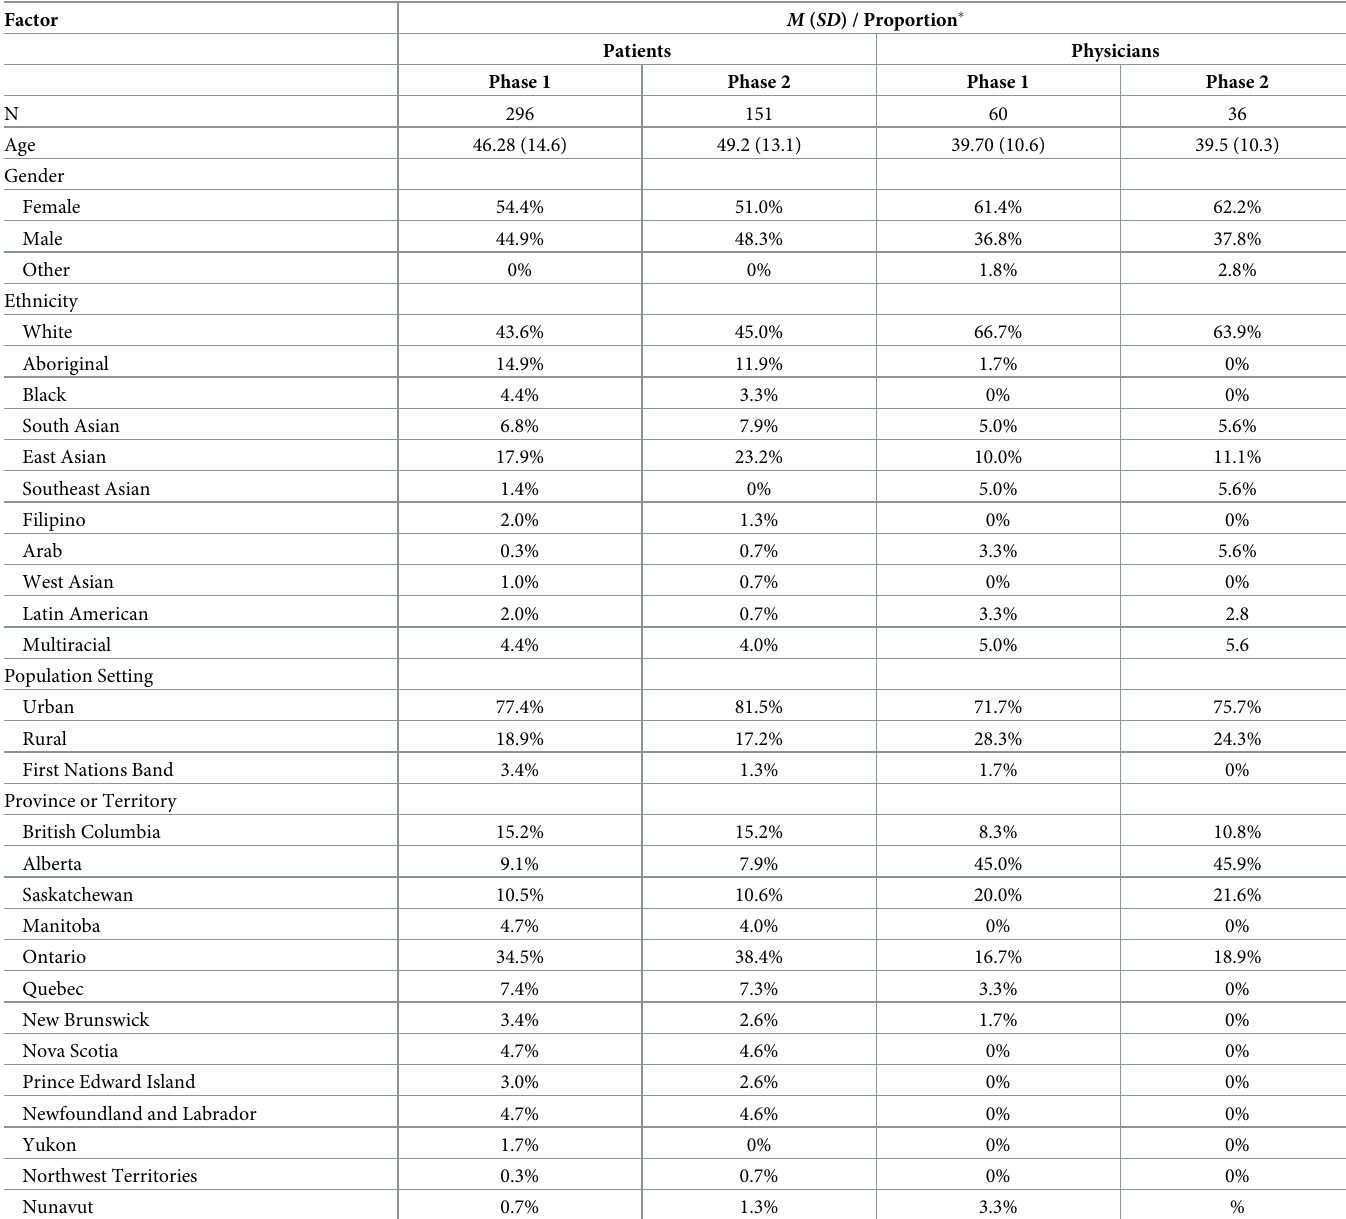
Table 1. Participants’ demographic